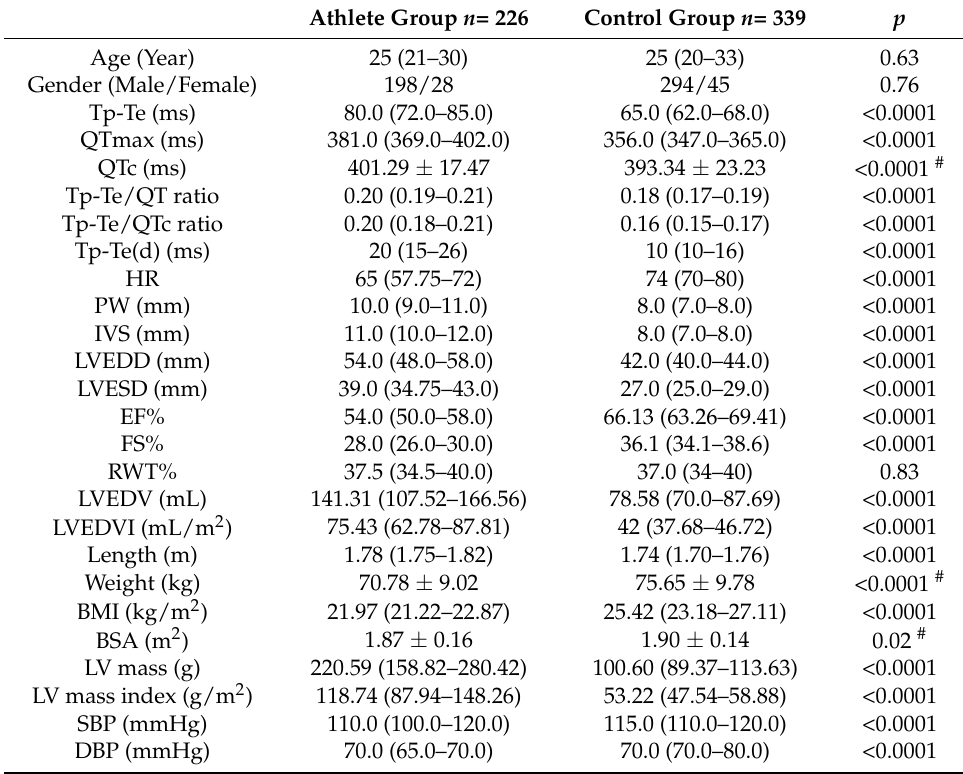
Table 1. Intergroup comparison of demographical and laboratory data.